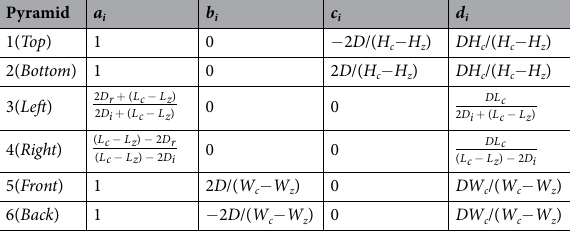
Pyramid a i b i